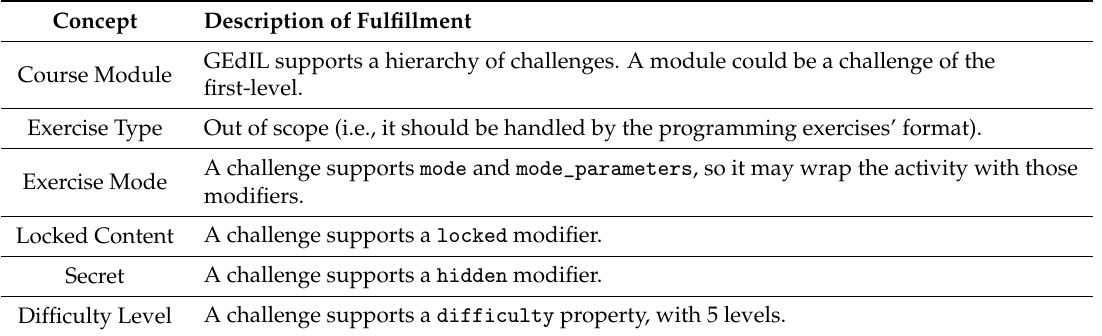
Table 1. Fulfillment of requirements from gamification concepts related to course organization.